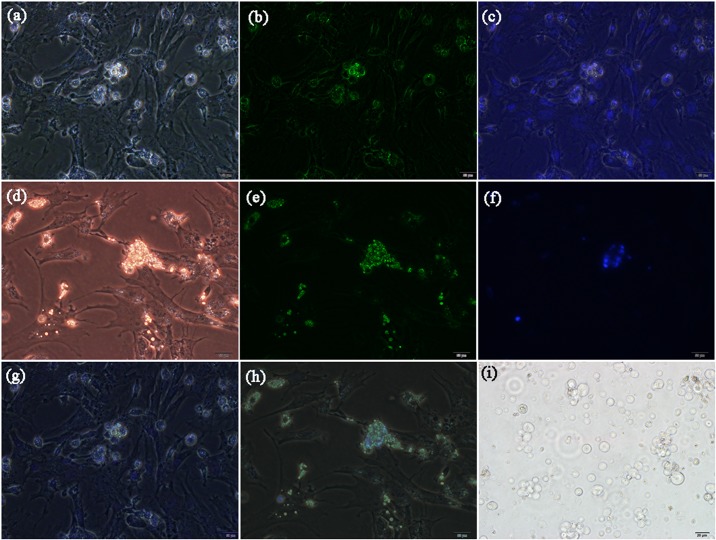
Identification of PGCs, SSCs, and Sp cells by flow cytometry sorting.The primordial germ cells (PGCs) and spermatogonial stem cells (SSCs) were cultured for 48 hours. The spermatogonia (Sp) cells were isolated directly from testes. (a) The PGCs capture in light (200×), (b) the PGCs identified with c-kit antibody marked with FITC and capture in dark (200×), (c) the PGCs stain with DAPI and capture in dark (200×), (g) it was a merge figure include (a-c). (d) The SSCs capture in light (200×), (e) the SSCs marked with integrin alpha 6 antibody (FITC) (200×), (f) the SSCs stain with DAPI and capture in dark (200×), (h) it was a merge figure include (d-f). (c) The Sp cells were collected by flow cytometry (200×). (i) The Sp cells were isolated and recorded in light. Bar = 20 μm.